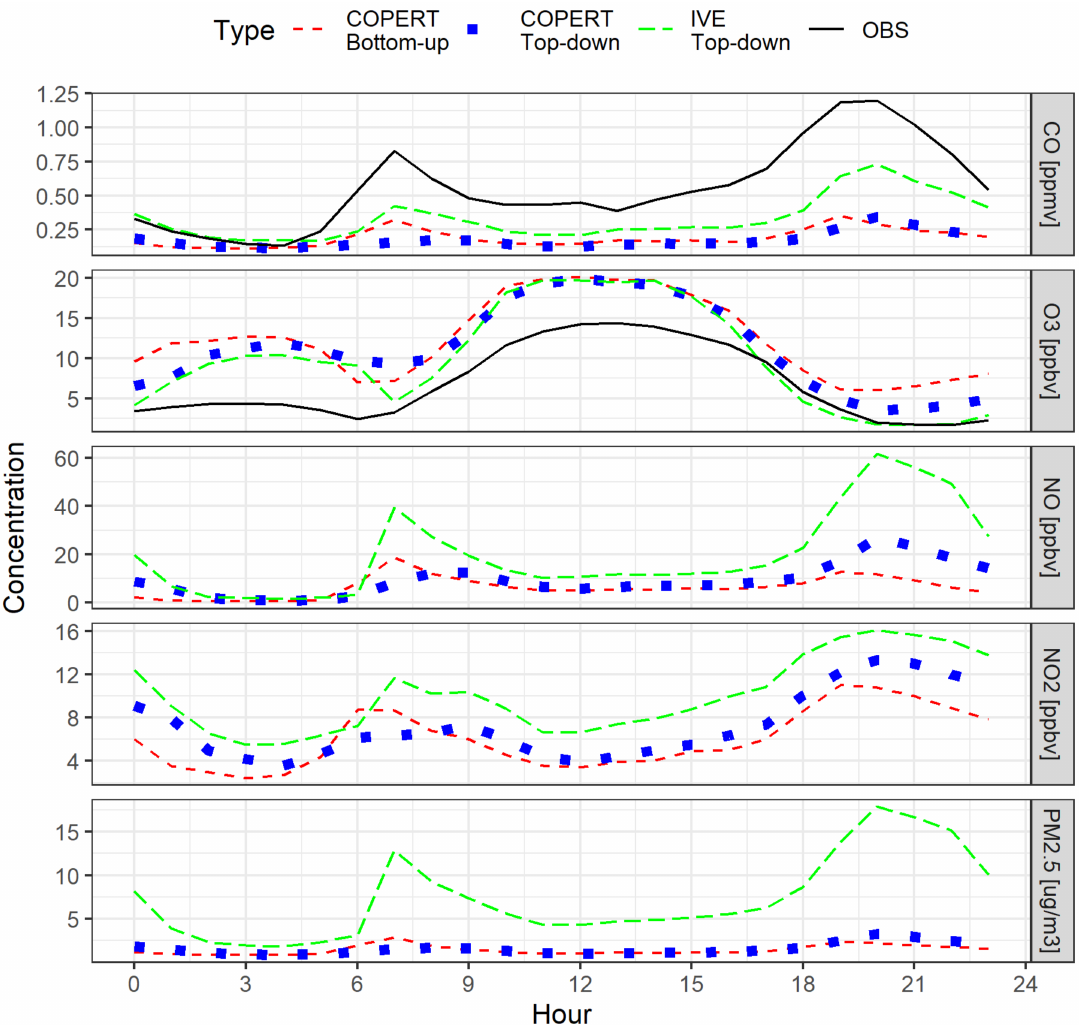
Figure 6. Average hourly profiles of CO, O 3 , NO, NO 2 , and PM 2.5 at GOB